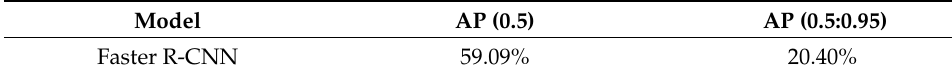
Table 3. Performance of missing tooth regions detection model.